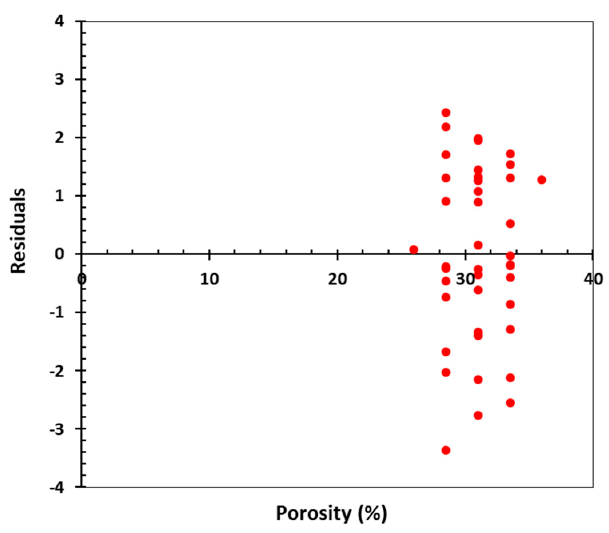
Figure 19. Residuals vs. product of steam injection rate and quality for the database analyzed.